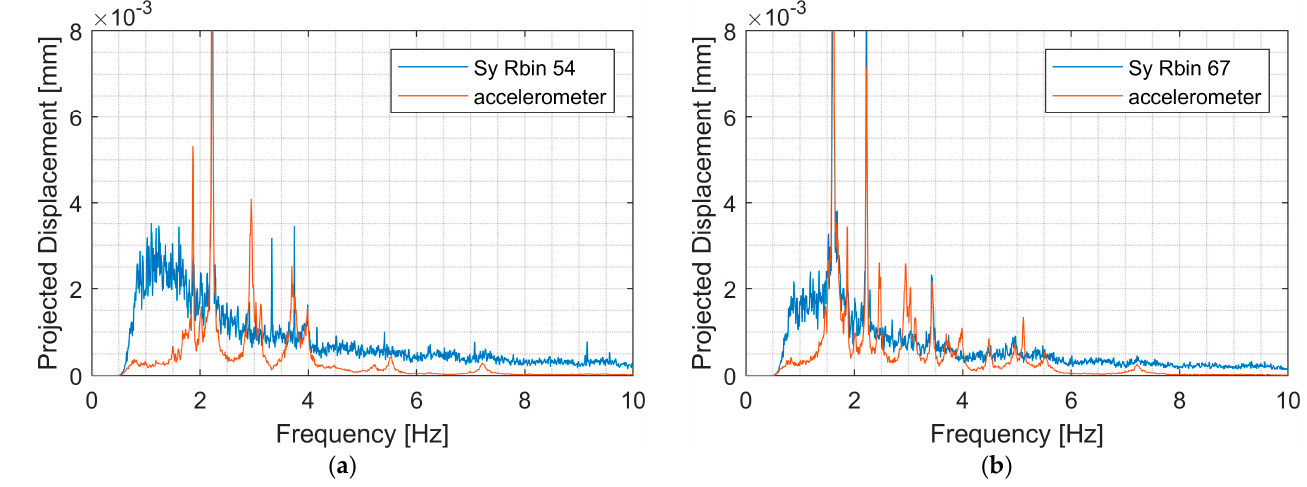
Figure 27. Frequency spectra (periodograms)—natural, significant, and distinct frequencies of the observed bridge measured by accelerometer: 1.87, 2.23, 2.95, 3.78, 3.99, 5.52, and 7.22 Hz and by radars (Sy Rbin 54): 1.88, 2.22, 3.32, 3.74, and 3.99 Hz ( a ) and by accelerometer: 1.61, 1.87, 2.23, 2.46, 2.95, 3.43, 3.70, 3.99, 4.48, and 5.12 Hz and by radars (Sy Rbin67): 1.61, 1.80, 2.22, 3.42, and 3.74 Hz ( b ).